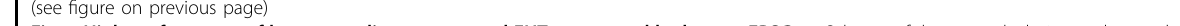
Fig. 1 High-performance of human cardiomyocytes and EHTs generated by human EPSCs. a Scheme of the research design and procedures. For cardiomyocyte differentiation, EPSCs were pretreated with mTeSR TM 1 medium for 2 days and then administrated by Wnt signaling modulators. ESCs/iPSCs were cultured in mTeSR TM 1 for 3 days, followed by the same differentiation protocol. On day 15, the generated cardiomyocytes were digested and reseeded on a monolayer or engineered heart tissue for functional assessment. On days 20 – 22, the cardiomyocytes were injected into the infarcted nude rat heart for injury recovery experiments. b Bright fi eld, immuno fl uorescence staining of cardiomyocyte markers SAA and CTNT, fi broblast marker Vimentin on day 15 (middle), and transmission electron microscopy showing myo fi brillar alignment in EHTs of both cell types. c Statistics of CTNT + rate at day 15 of differentiation by fl ow cytometric analysis ( n = 9 for iPSC group, n = 11 for EPSC group). d Gene ontology analysis of cardiac-related biological processes for up-regulated genes in EPSC-CMs vs iPSC-CMs on day 15 of differentiation. ( n = 3 biological replicates in each group). e Representative light microscopy images of cardiac bundles from iPSC-CMs and EPSC-CMs; H&E staining images from longitudinal and cross-sections showing well-arranged myo fi ber. f Bright fi eld and immuno fl uorescence staining of SAA and N-cadherin showing tight conjunction among cardiomyocytes in EPSC-CM- and iPSC-CM-derived bundles; while well-arranged RYR2 only presented in a 2-week EPSC- CM-constructed bundle. g Representative confocal images and quantitative analysis (right) of live MitoTracker staining in reseeded iPSC-CMs and EPSC-CMs with the indicated time points. n = 6 – 8. h Real-time oxygen consumption rate (OCR) measurements of iPSC-CMs and EPSC-CMs reseeded for 8 days (left), and calculation of coupling ef fi ciency (right) by Seahorse extracellular fl ux analyzer ( n = 5 per group). i GSEA showing enrichment plots of gene expression signatures of oxidative phosphorylation pathway in EPSC-CMs vs iPSC-CMs on day 15. j Representative images and Ca 2 + transients (left) of iPSC-CMs and EPSC-CMs. Cells were loaded with Fluo-4 AM and paced for 15 s at 1 Hz one time, and then Ca 2 + transients were recorded post-pacing by confocal line scan imaging. Quanti fi cation of Ca 2 + transient amplitude of fl uorescence changes, maximum upstroke speed, and duration at 50% repolarization (CaTD50) (right) in both cell types. More than 50 cells from three biological replicates per group were recorded. k , l Optical mapping of 2-week iPSC-CM and EPSC-CM patches stimulated at 1 Hz pacing. Isochronal activation maps ( k left) and calcium transient traces ( k right), as well as vector illustrations and statistics of distributions towards propagating directions ( l ) were shown, respectively. n = 9 for iPSC- CM group, n = 11 for EPSC-CM group. m Active force traces in iPSC-CM- and EPSC-CM-derived bundles spontaneously or at various pacing rates ( m left) and maximum captured pacing rate ( m right). n = 9 – 10 in each group. n Representative images of the cardiac bundle at original state or 10% stretch. o , p Corresponding active force ( o ) and passive force ( p ) in 2-week cardiac bundle made with iPSC-CMs and EPSC-CMs during the progressive stretch of an electrical stimulation (2 Hz), respectively. q Contractile force amplitude in response to different isoproterenol concentration ( n = 5). r Representative echocardiographic images (left) and quanti fi cation of left ventricular ejection fraction (LVEF) (right) at 6 weeks after LAD coronary artery ligation and iPSC-CM/EPSC-CM grafting. n = 6 rats in MI + vehicle group, n = 5 rats in MI + iPSC-CM group, n = 6 rats in MI + EPSC- CM group. s Representative images (left) and quanti fi cation (right) of the infarcted area from Masson staining from heart sections in each group. t Representative histological images and quanti fi cations of iPSC-CM and EPSC-CM ’ s engraftments in the hearts at 6 weeks after cell transplantation. H&E, Masson and immunostaining images of KU80 and SAA showed the survived engraftments in rat hearts. The EPSC-CM group exhibited comparable engraftment size but a reduced percentage of fi brotic area in grafts ( n = 4 rats per group). u Representative images and quanti fi cation (right) of TUNEL staining in the grafts ( n = 4 rats per